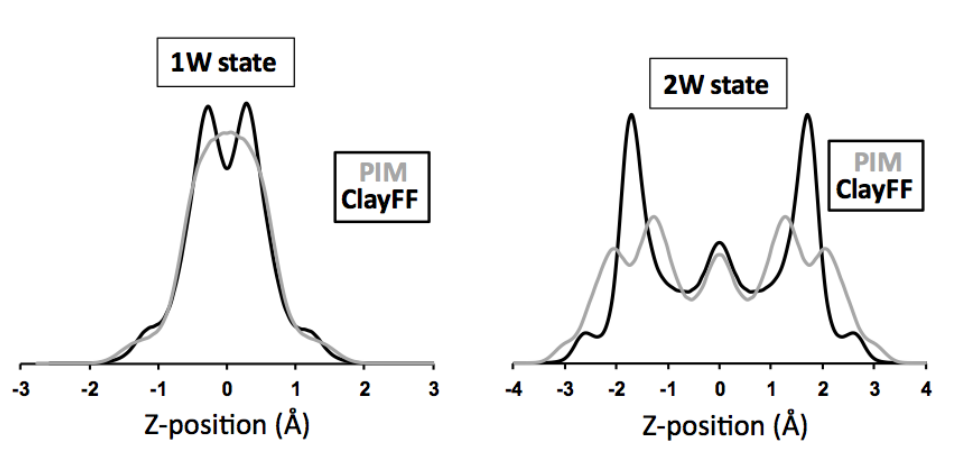
Figure 5. Interlayer electronic density profiles (arbitrary units) calculated from atomic density profiles generated using PIM (gray) or ClayFF (black) models for monohydrated (1W-left) and bihydrated (2W-right) hydration states. Atomic Z coordinates (in Å) are given relative to the mid-plane of the